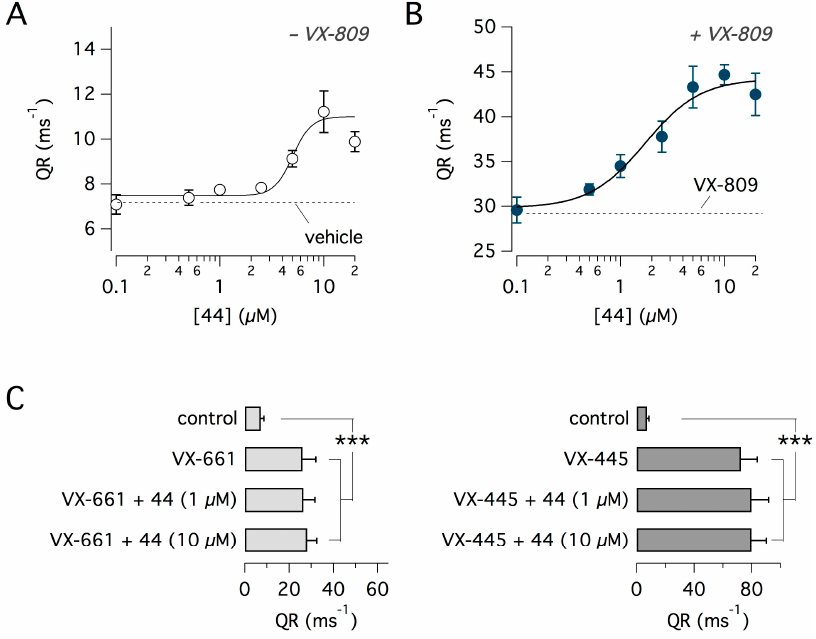
Figure 4. Characterization of compound 44 . ( A , B ) Dose-response relationships obtained by incubating cells with different concentrations of compound 44 in the absence ( A ) and presence ( B ) of VX-809 at 1 μ M. After incubation, F508del-CFTR activity in the plasma membrane (i.e., anion transport reported as QR) was determined with the HS-YFP assay. Each symbol shows mean ± SD from six separate experiments. Fitting of data with a Hill equation showed a half-effective concentration of 5 and 1.7 μ M in the absence and presence of VX-809, respectively. ( C ) Effect of combinations of compound 44 (at 1 and 10 μ M) with 5 μ M VX-661 (left) or 5 μ M VX-445 (right). The two types of combinations did not result in additive effects. Each bar is the mean ± SD of eight experiments. ***, p <0.001 vs. control.